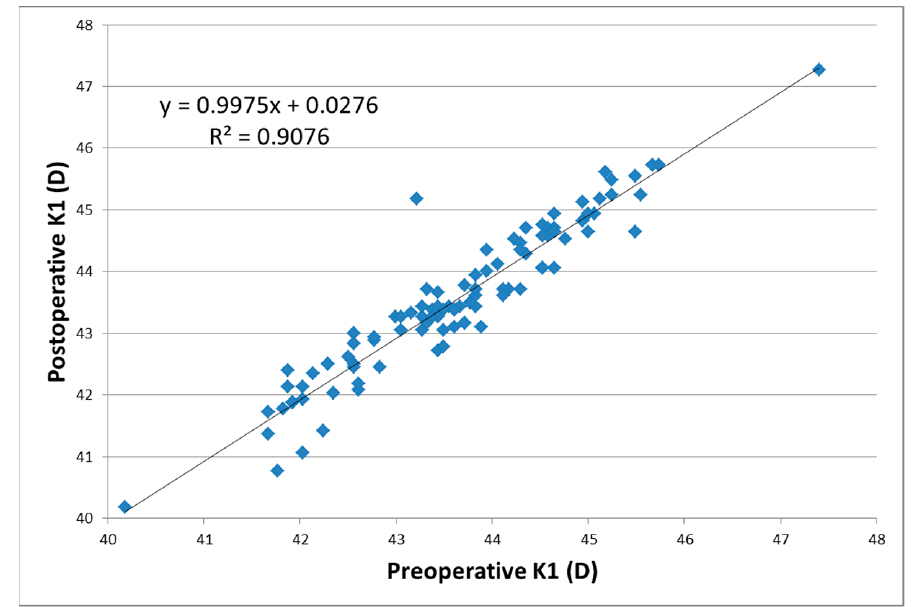
Figure 4. Correlation between the postoperative and preoperative values of K1.